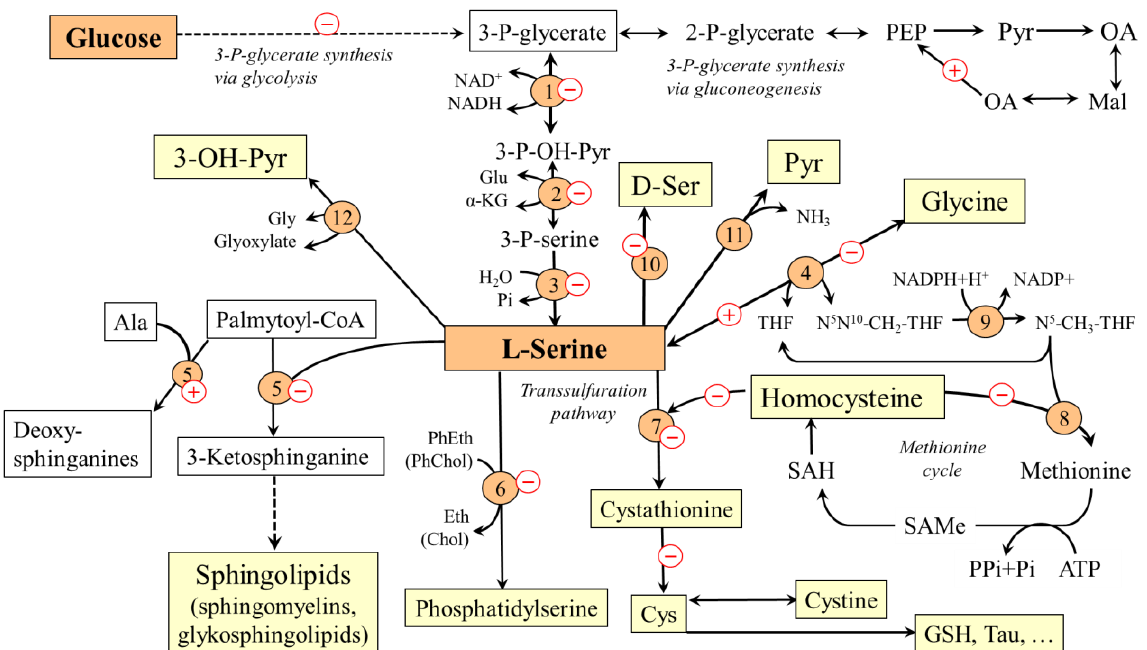
Figure 2. Main pathways of L-serine metabolism and their alterations during diabetes mellitus. The pluses and minuses indicate the predicted changes in diabetes. 1, 3-phosphoglycerate dehydrogenase; 2, phosphoserine aminotransferase; 3, phosphoserine phosphatase; 4, serine hydroxymethyltransferase; 5, serine palmitoyltransferase; 6, phosphatidylserine synthase; 7, cystathionine β-synthase; 8, methionine synthase; 9, methylene tetrahydrofolate reductase; 10, racemase 11, serine dehydratase; 12, serine-glyoxylate transaminase. Chol, choline; Eth, ethanolamine; GSH, glutathione; OA, oxaloacetate; Mal, malate; Pyr, pyruvate; PEP, phosphoenolpyruvate; PhChol, phosphatidylcholine; PhEth, phosphatidylethanolamine; SAH, S-adenosylhomocysteine; SAMe, S-adenosylmethionine; 3-OH-Pyr, 3-hydroxypyruvate.